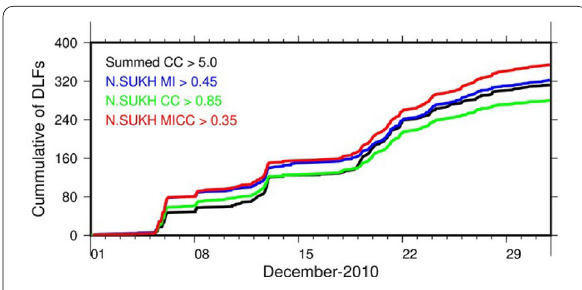
Fig. 11 Cumulative number of detected DLF earthquakes based on each index during December 2010